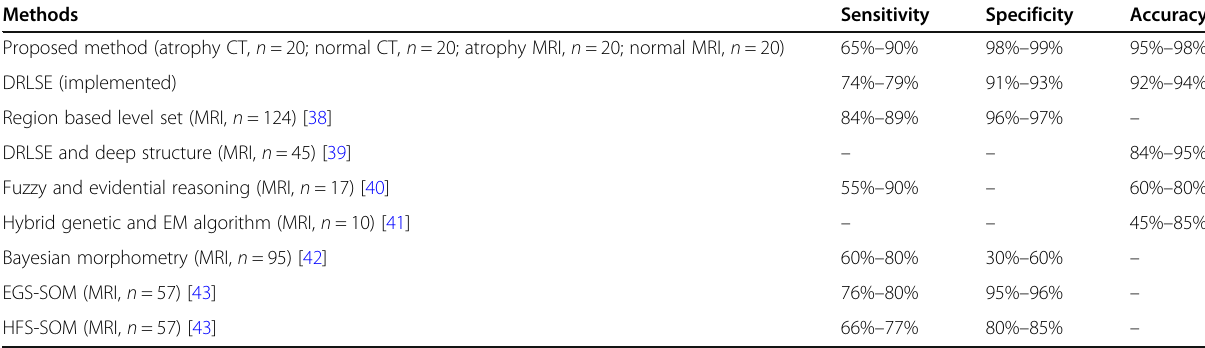
Table 2 Results of the comparison of the proposed method with other segmentation methods from the literature